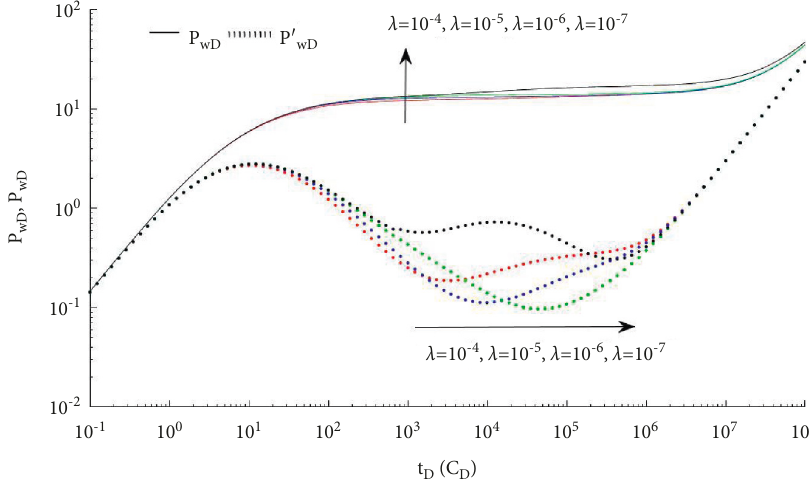
Figure 11: Dimensionless pressure of vertical wells under the close outer boundary influenced by λ ( C